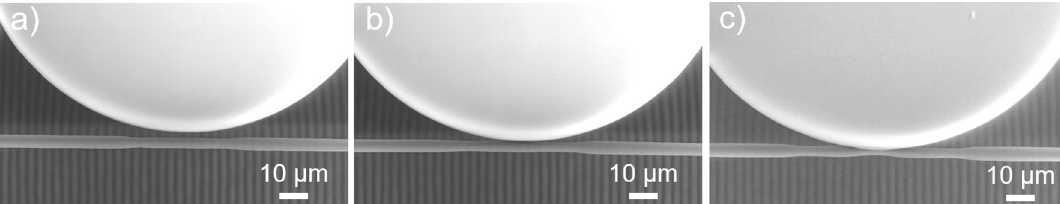
Figure 4. Coupling between the Suspended Waveguide and the Microdisk. SEM images illustrating the possible assembly scenarios: the suspended waveguide is ( a ) separated from the microdisk, ( b ) tangent to the microdisk, and ( c ) merged with the